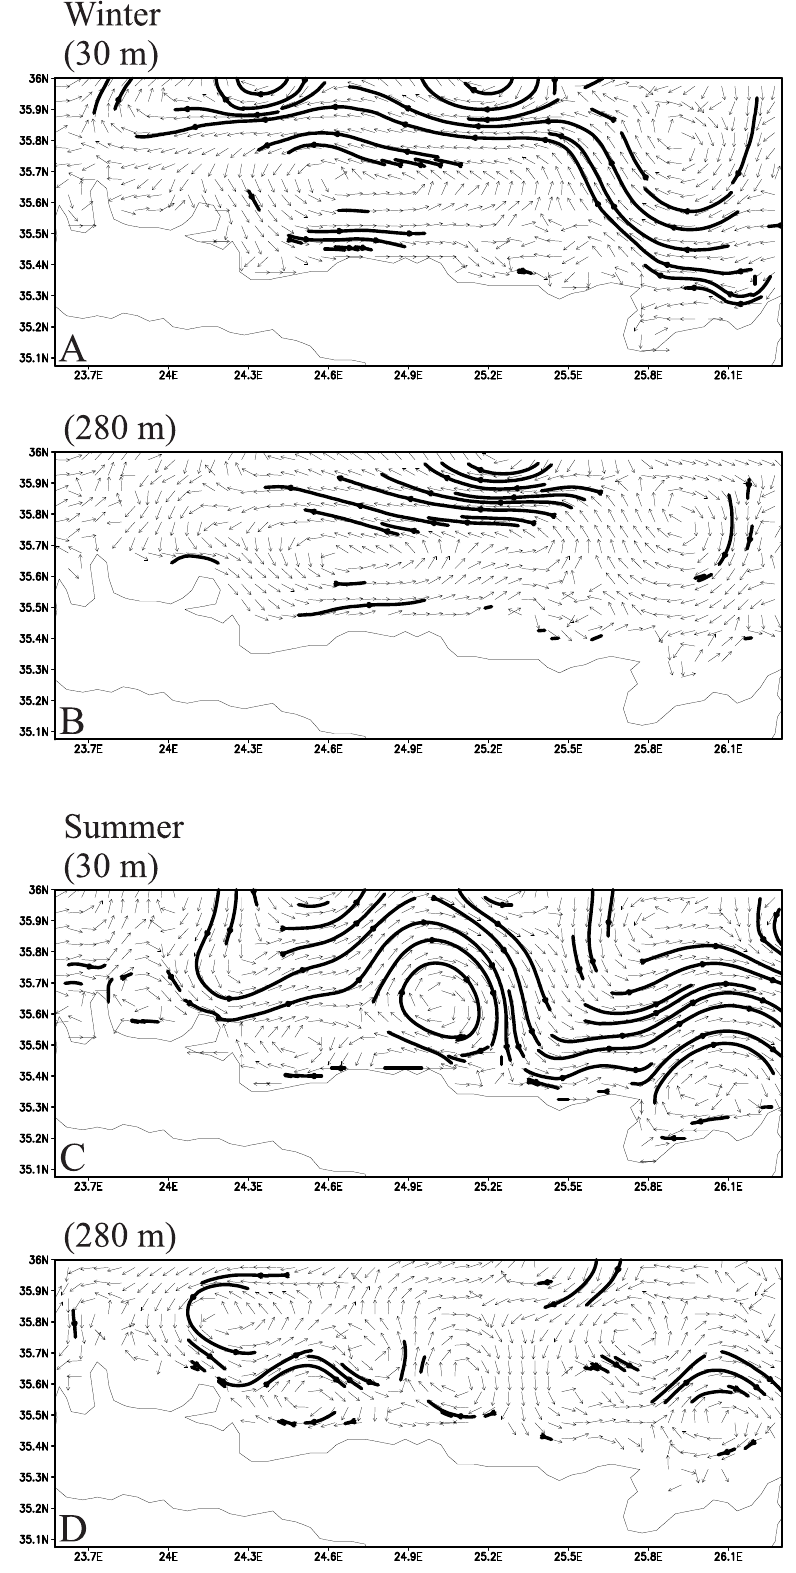
Fig. 5. Circulation patterns in the modelling area of the Cretan Sea corresponding to the third perpetual year simulation SI-MO. (a) Winter (February) sub-surface (30m), (b) Winter (February) mid-depth (280m), (c) Summer (August) sub-surface (30m), (d) Summer (August) mid-depth